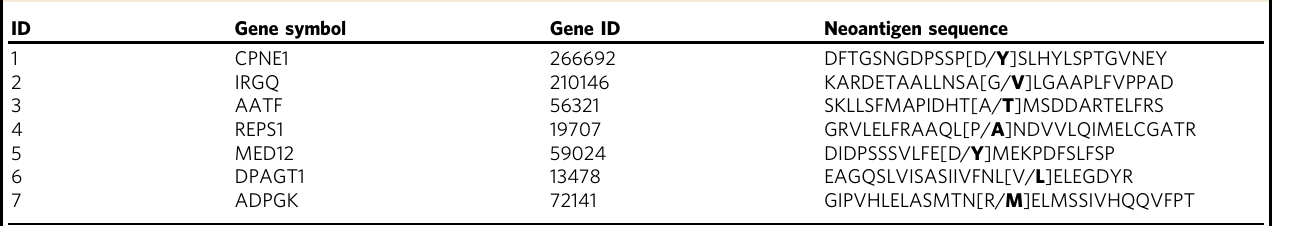
List of the MC38 neoantigens encoded by GAd-MC38-7 vaccine. The mutated amino acid is in bold next to the wild-type amino